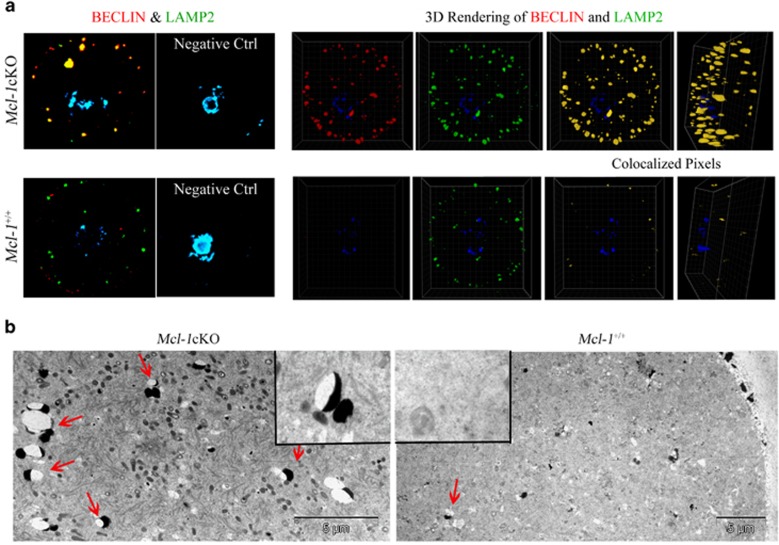
Markers of autophagy in GV oocytes. (a) Confocal image of Beclin-1 (red) and LAMP-2 (green) foci in isolated GV oocytes from 3-week ovaries, counterstained with DAPI (blue). To determine colocalization, 3D rendering of all layers was performed on n=19 Mcl-1cKO and n=13 Mcl-1+/+GV oocytes with colocalized (yellow) pixels displayed. Coefficients of colocalization for Mcl-1cKO oocytes compared with Mcl-1+/+(Pearsons (PCC)=0.51±0.05 to 0.17±0.07, respectively; P<0.001) (Manders A (MCC-A)=0.098±0.017 to 0.058±0.01, respectively; P<0.05) (Manders B (MCC-B)=0.079±0.014 to 0.032±0.005, respectively; P<0.05) (b) Transmission electron microscopy (TEM) of Mcl-1cKO and wild-type control GV oocytes with lysosome-associated vesicles (red arrows) indicated